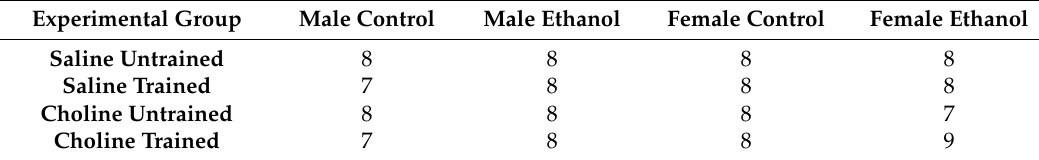
Table 1. Number of animals per